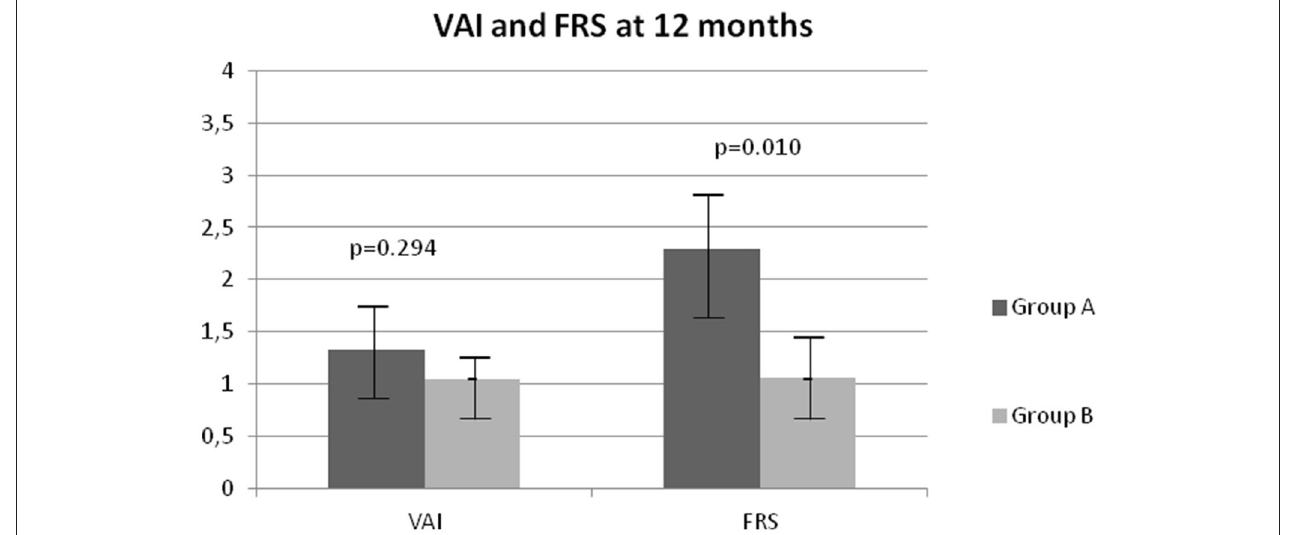
FIGURE 2 | Comparison of Visceral Adiposity Index (VAI) and Framingham Risk Score (FRS) after 12 months in groups A and B.